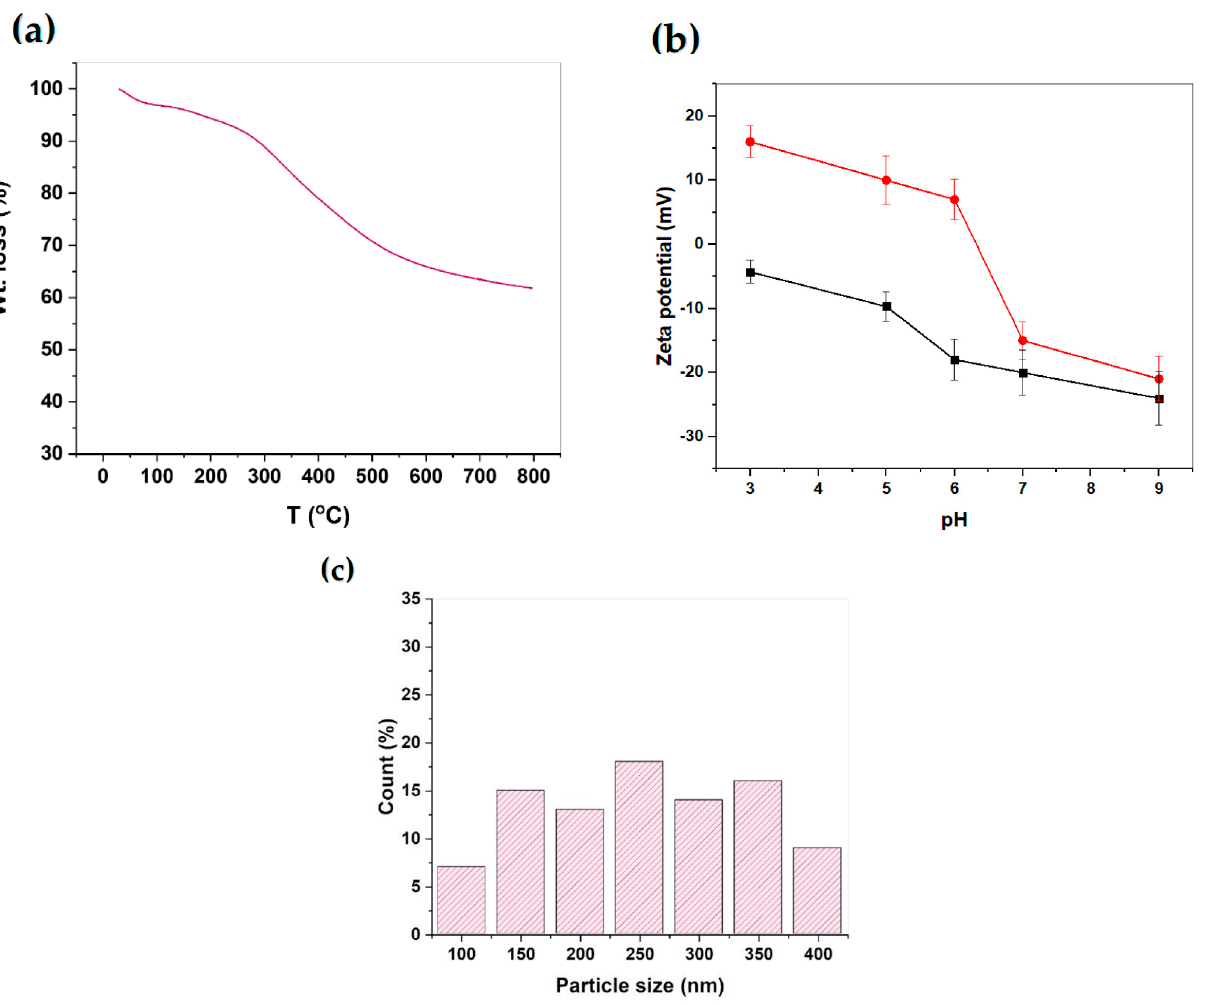
Figure 3. ( a ) TG analysis of MSH@MA NPs. ( b ) Zeta potential of MSH@MA NPs (red line) and MSNs (black line). ( c ) Particle size distribution of the MSH@MA NPs.